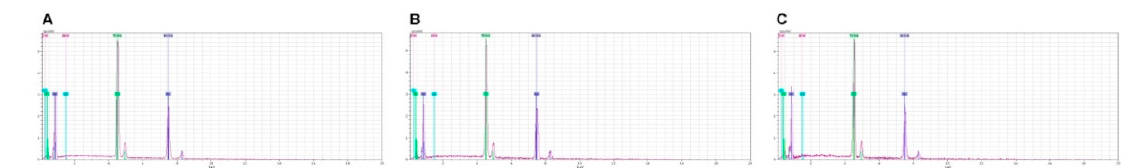
Figure 10. EDX micro-analysis of M-Wire alloy PTN endodontic rotary files at locations ( A ) 1, ( B ) 2, and ( C ) 3.